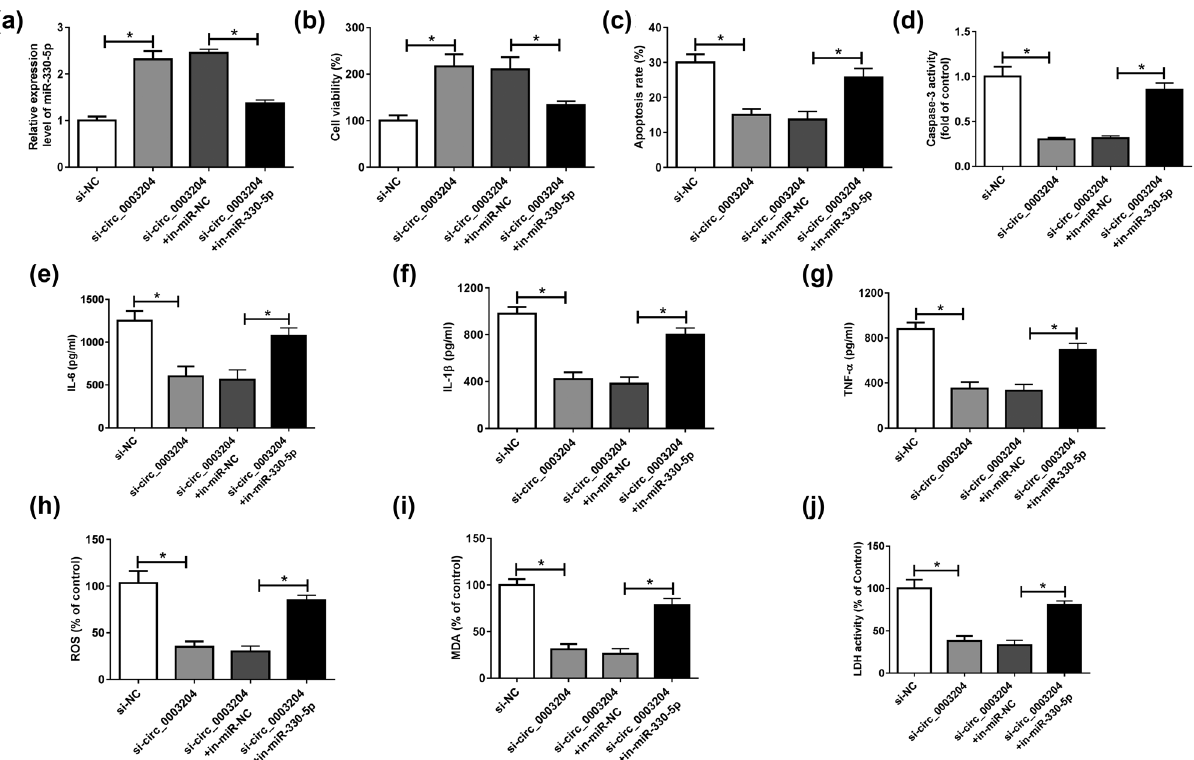
Figure 4: E ff ects of miR - 330 - 5p inhibitor on ox - LDL - induced HUVECs injury. HUVECs were transfected with si - NC, si - circ_0003204, si - circ_0003204 + in - miR - NC, or si - circ_0003204 + in - miR - 330 - 5p, followed by treatment with ox - LDL. ( a ) The expression of miR - 330 - 5p was measured using qPCR. ( b ) CCK8 assay was performed to test the viability of HUVECs. ( c ) The apoptosis of HUVECs was determined via fl ow cytometry. ( d ) Caspase - 3 Activity Assay Kit was used to assess the activity of caspase - 3. ( e – g ) The contents of IL - 6, IL - 1 β , and TNF - α were detected using the IL - 6, IL - 1 β , and TNF - α ELISA Assay Kits, respectively. ( h – j ) The ROS, MDA, and LDH Assay Kits were used to measure the expression of ROS and MDA and the activity of LDH. * P <